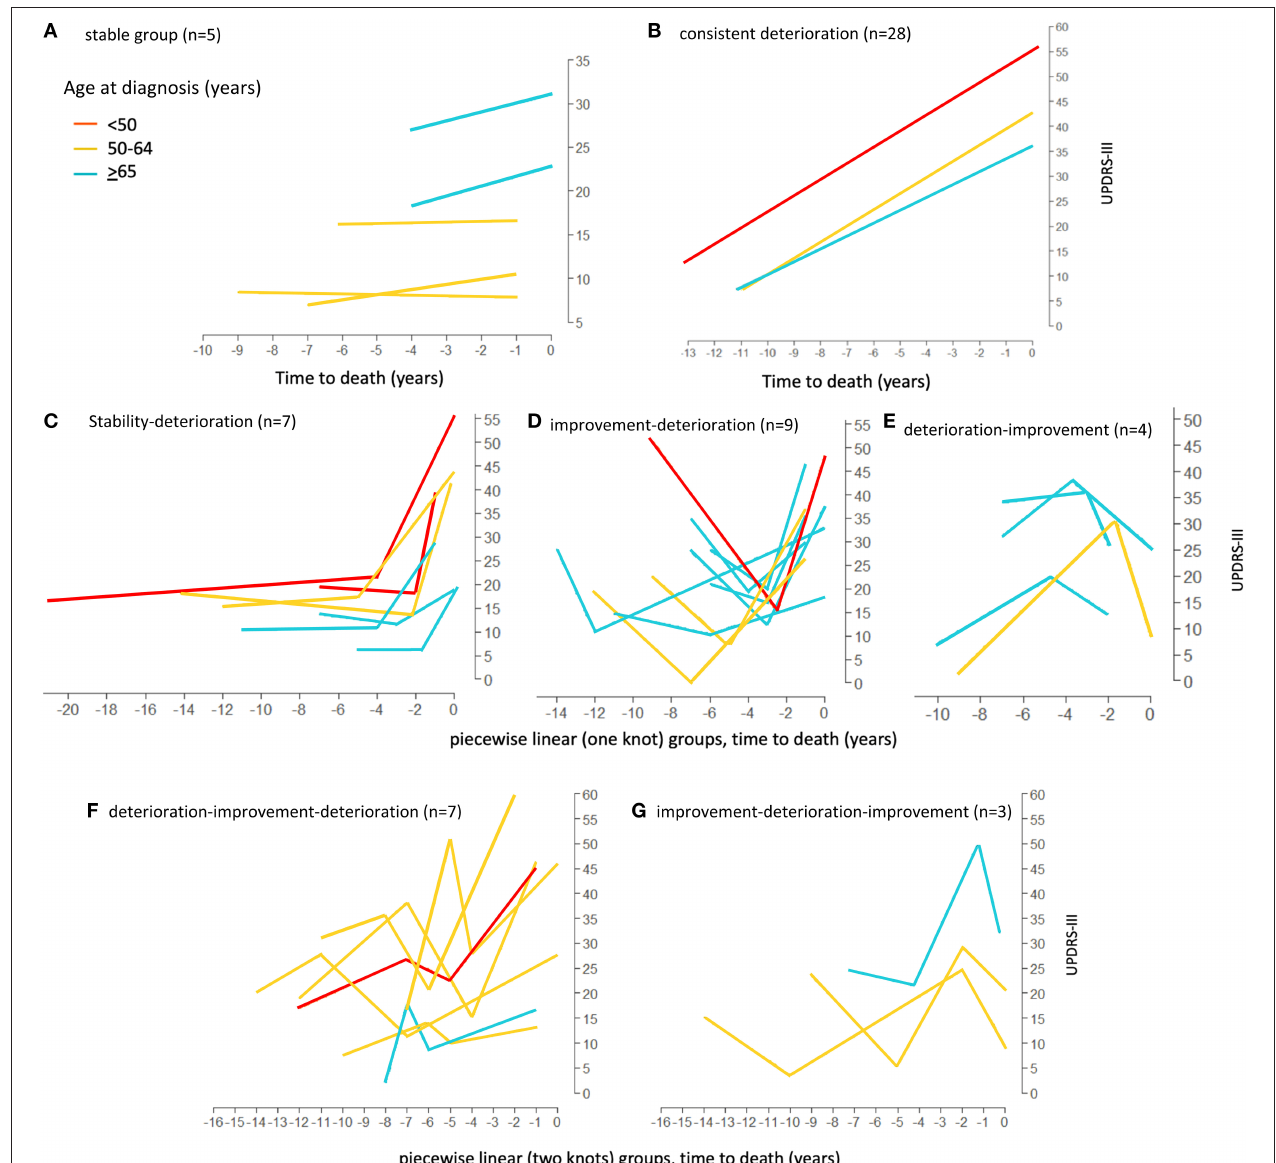
FIGURE 4 | Loess curves of UPDRS-III scores for Parkinson’s patients with model fitting. Loess curves were visualized on time prior to death for the 84 Parkinson’s patients analyzed. The curve was stratified by age at diagnosis, < 50, 50–64, and ≥ 65 years. The individual model fittings are: (A) stable group, n = 5. (B) linear trend (Consistent deterioration) group (lines represent the average pattern for each age group), n = 28. (C–E) fitted trajectories for piecewise linear (one knot) groups. (C) Stability-Deterioration ( n = 7); (D) Improvement-Deterioration ( n = 9); and (E) Deterioration-Improvement ( n = 4). (F,G) fitted trajectories for piecewise linear (two knots) groups. (F) Deterioration-Improvement-Deterioration ( n = 7); (G) Improvement-Deterioration-Improvement ( n = 3). PD, Parkinson’s disease; UPDRS-III, Unified Parkinson’s Disease Rating Scale motor